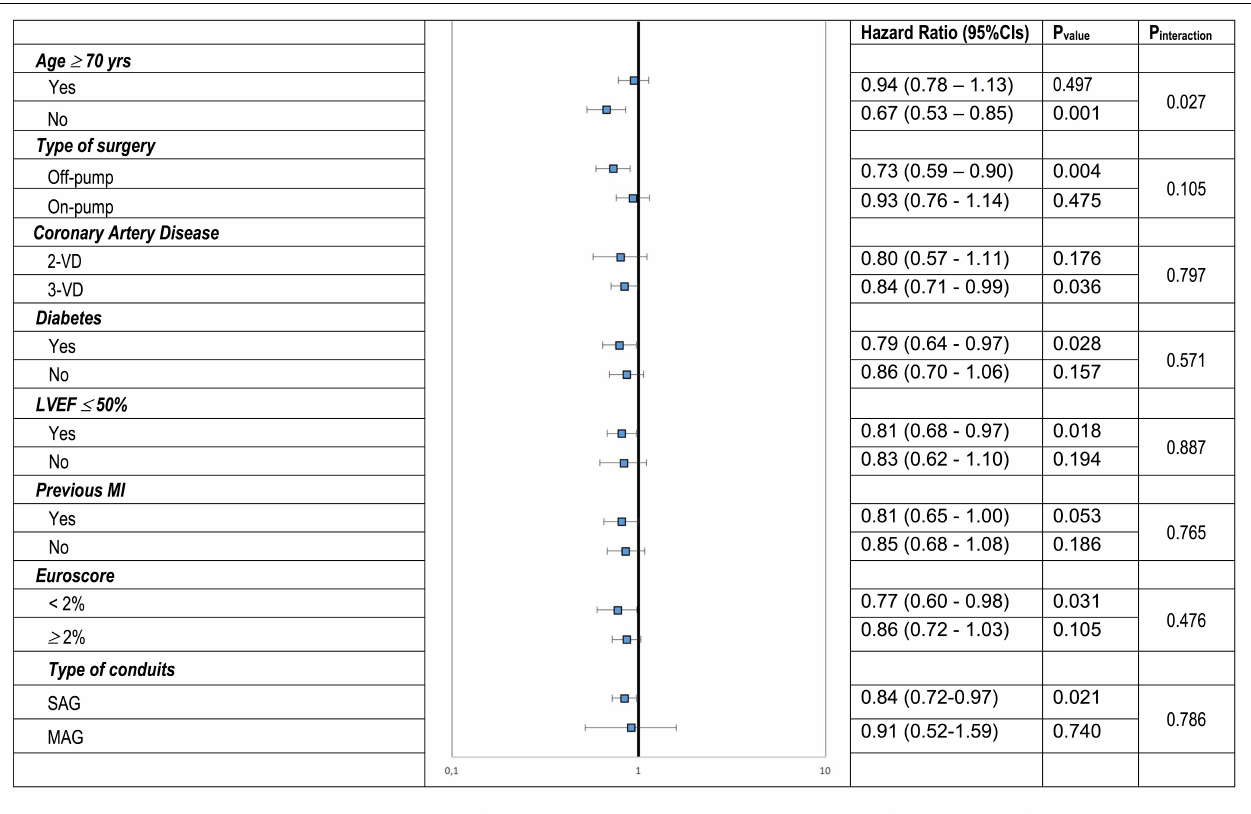
endpoint [HR (95% CIs) 1.66, (1.10–2.50), p = 0.013]